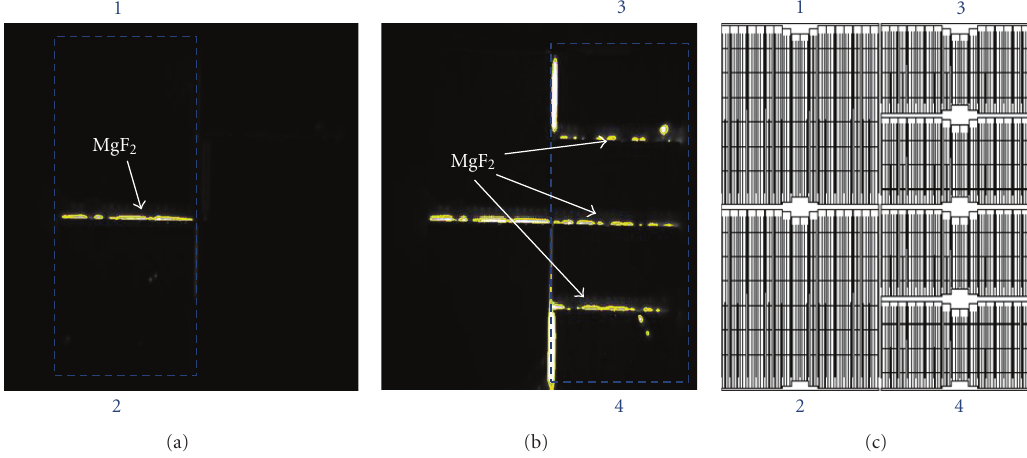
Figure 5: DLIT images of the sample from Table 2. (a, b) DLIT images for the cells with MgF 2 as the isolation material taken at the forward bias condition: 400 mV, lock-in frequency: 10 Hz, scale: − 0.1 mK to 1 mK; (a) image is for the 2-cell minimodule on the left biased at 1 and 2; (b) image is for the 4-cell minimodule on the right biased at 3 and 4. (c) Schematic of a fully metallised sample.